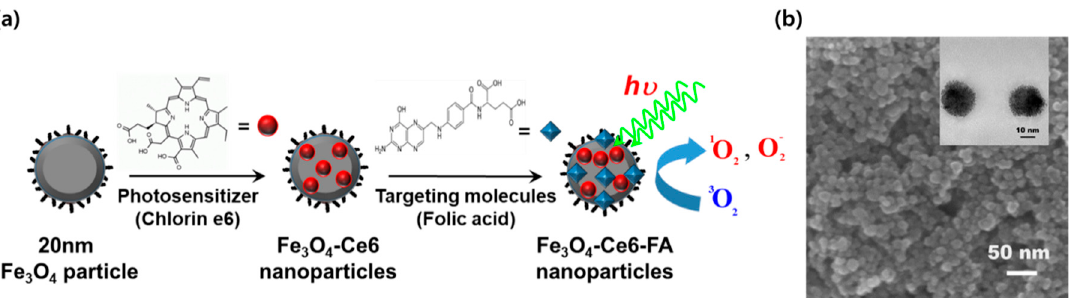
Figure 1. Scheme of synthesis procedure and electron microscope images of multifunctional magnetic nanoparticles (FCF NPs). ( a ) Scheme of fabrication procedure, ( b ) images of field-emission scanning electron microscope (FE-SEM) and TEM (small image).